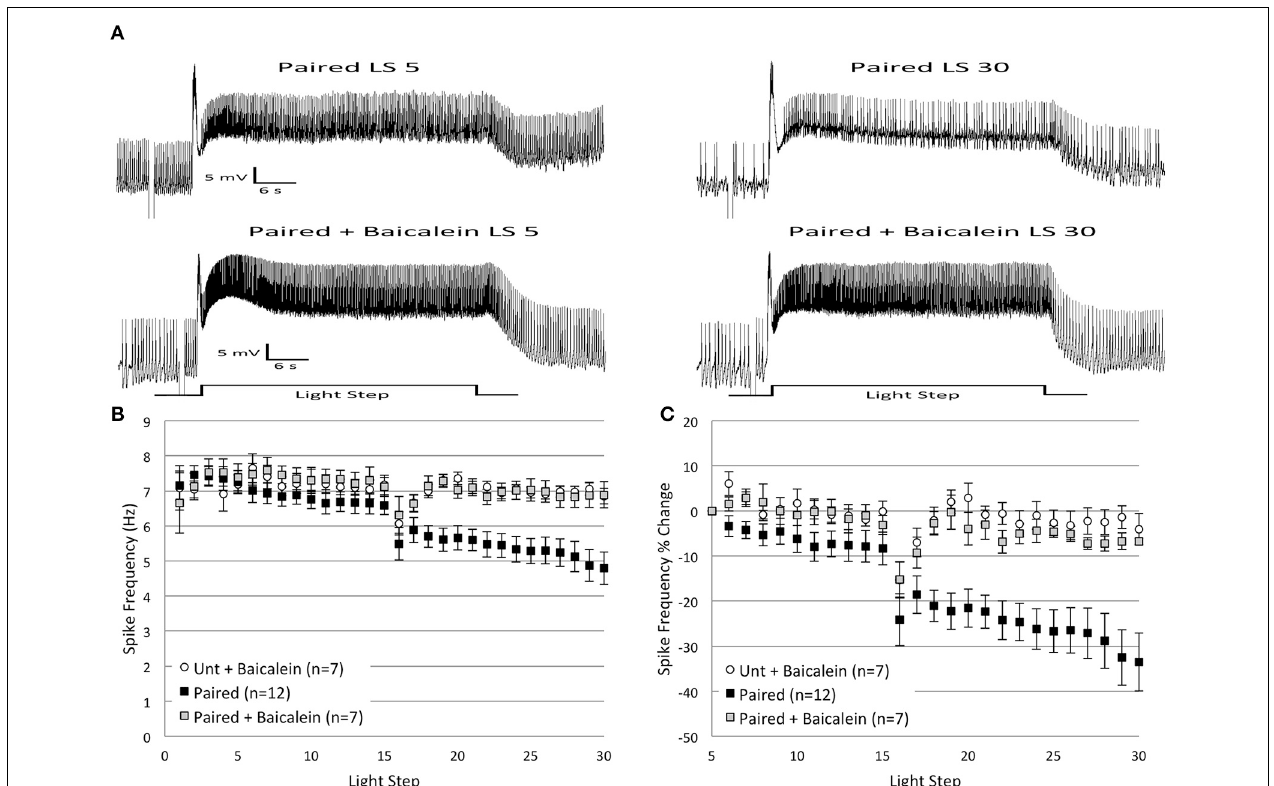
FIGURE 10 | Incubation of Paired Type B cells in baicalein (100 µ M final bath concentration) for 10min prior to in vitro extinction blocked the reduction in spike frequency produced by repeated LSs in Paired (no drug) cells. (A) Representative light responses recorded from a Paired Type B cell (top trace) and a Paired cell incubated in baicalein ( Paired + Baicalein ; bottom trace). The Paired cell showed a clear decline in spike frequency from the 5th to 30th LS, while the Paired + Baicalein cell did not. (B) Summary spike frequency data of Type B cells exposed to baicalein. The significant decrease in spike